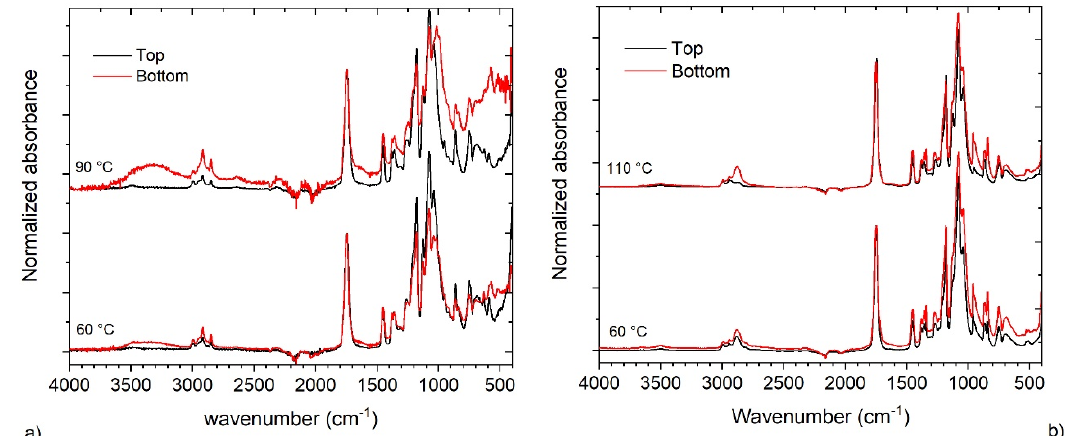
Figure 7. ( a ) FT-IR spectra of the top and bottom surfaces of PLA_SDS_starch films prepared at 60 and 90 °C; ( b ) FT-IR spectra of the top and bottom surfaces of PLA_SYN film prepared at 60 and 110 °C.